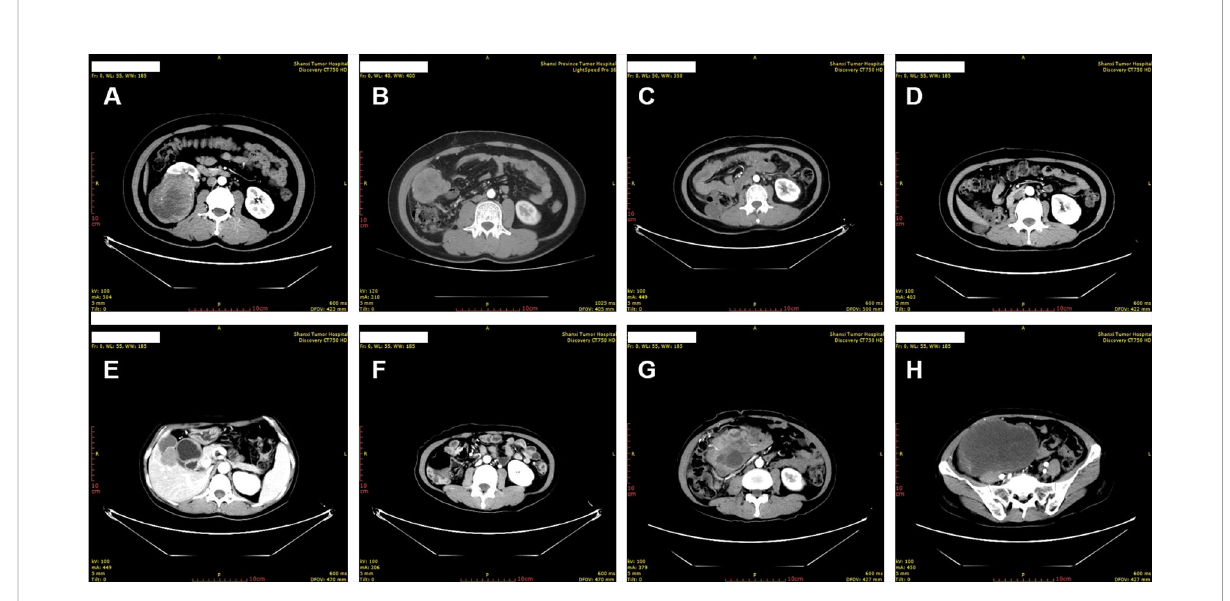
FIGURE 1 Chronological computed tomography of the perivascular epithelioid cell tumor. (A) The primary tumor was identi fi ed as right kidney mass. (B) Metastases were identi fi ed in the right abdominal cavity 10 months after resection of the primary tumor. (C, D) Shrinkage of the abdominal cavity tumor was identi fi ed 3 months (C) and 6 months (D) after the initiation of anti-VEGFR TKI treatment, respectively. (E, F) Continuous shrinkage of the abdominal cavity tumor and appearance of new metastases in gallbladder fossa was identi fi ed 15 months after the initiation of anti-VEGFR TKI treatment. (G, H) New, widespread metastases were identi fi ed in the abdomen and pelvis 15 months after the initiation of the MTOR inhibitor everolimus